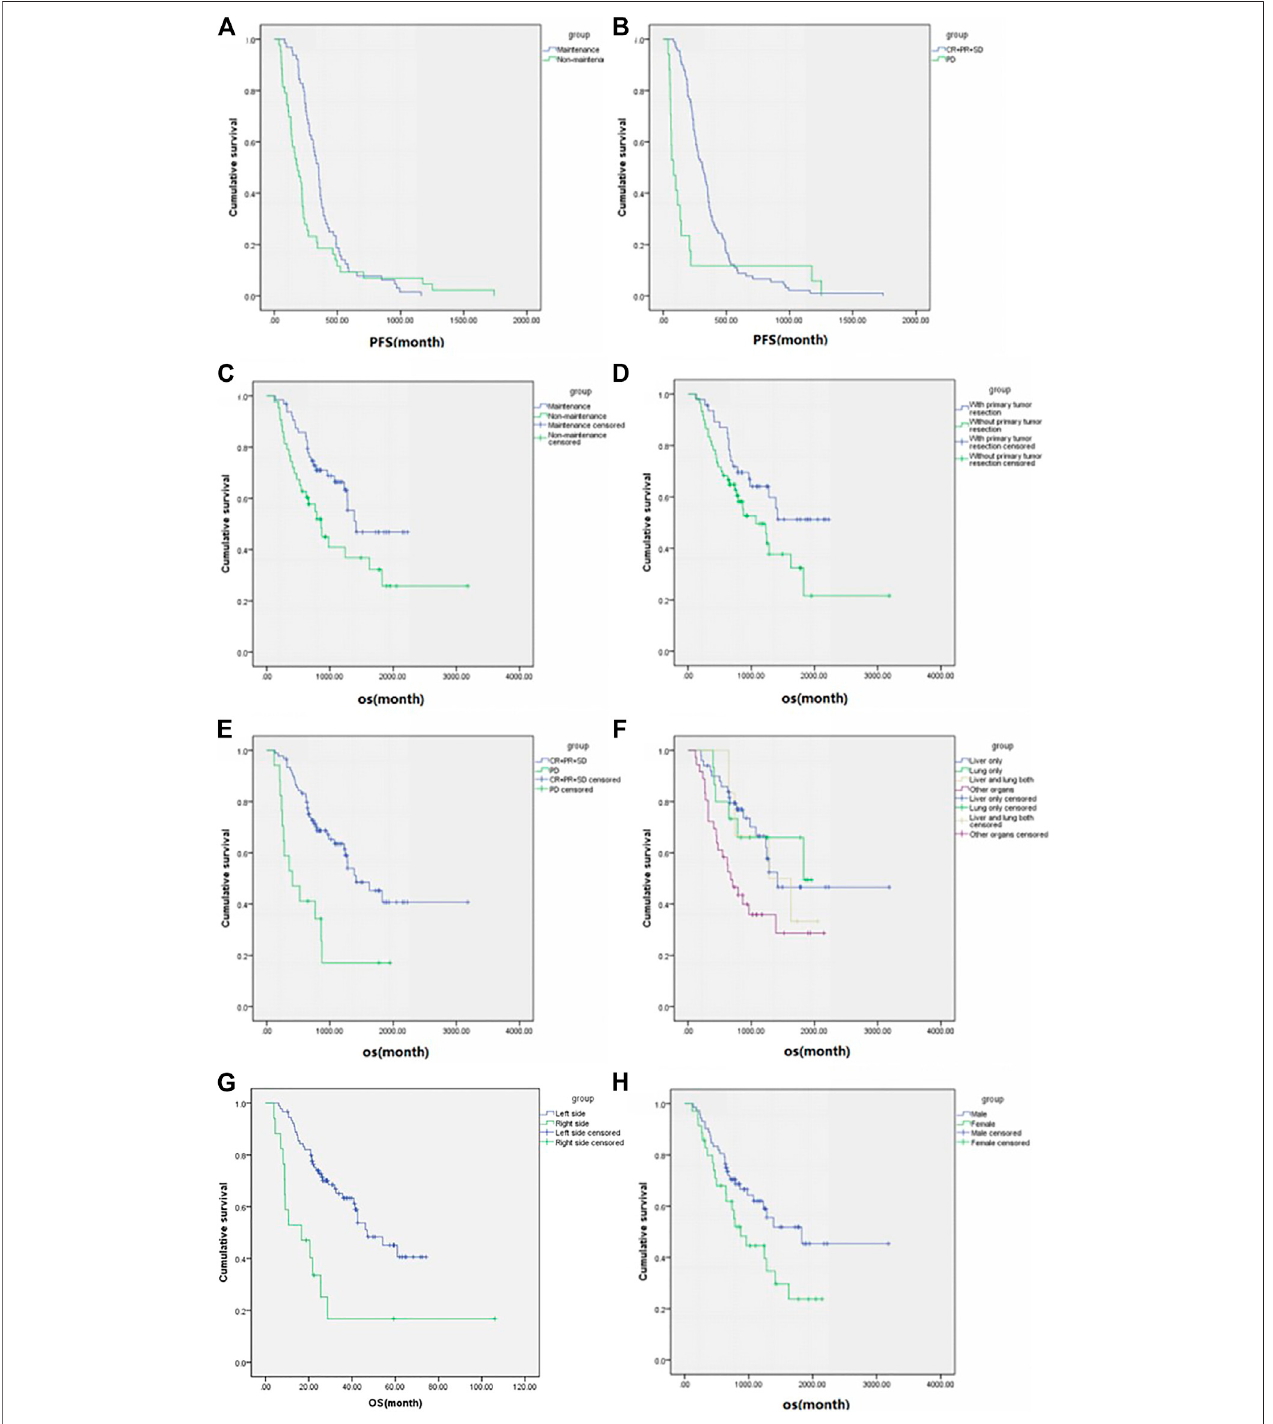
FIGURE 4 | Subgroup analysis (according to the variables in Table 3 ) of progression-free survival and overall survival in patients who had progression information ( n (cid:1) 107).Progression-freesurvivalof (A) maintenanceornotand (B) bestoverallresponseandoverallsurvivalof (C )maintenanceornot, (D) primarytumorresection, (E) best overall response, (F) metastases sites, (G) primary tumor resection and (H) sex.